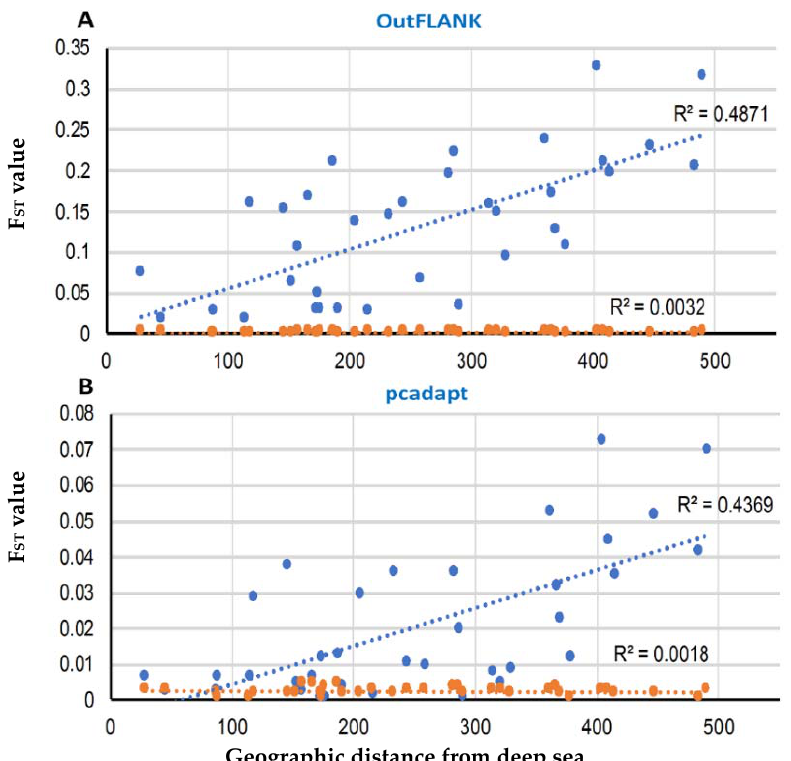
Figure 9. Correlation of the pairwise F ST value with the pairwise geographical distances among the T. ilisha collection sites in the F ST OutFLANK ( A ) and pcadapt approaches ( B ). The blue circle represents the putatively adaptive loci F ST , and the red circles are the putatively neutral loci F ST . The Mantel test showed highly significant effects based on 9999 replicates.